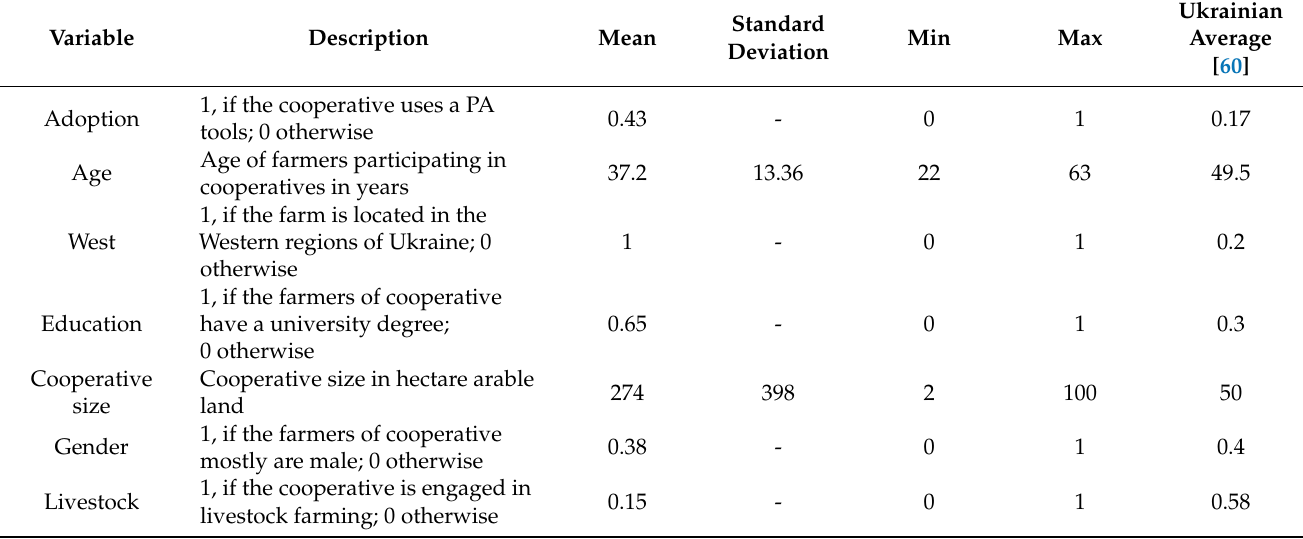
Table 1. Descriptive